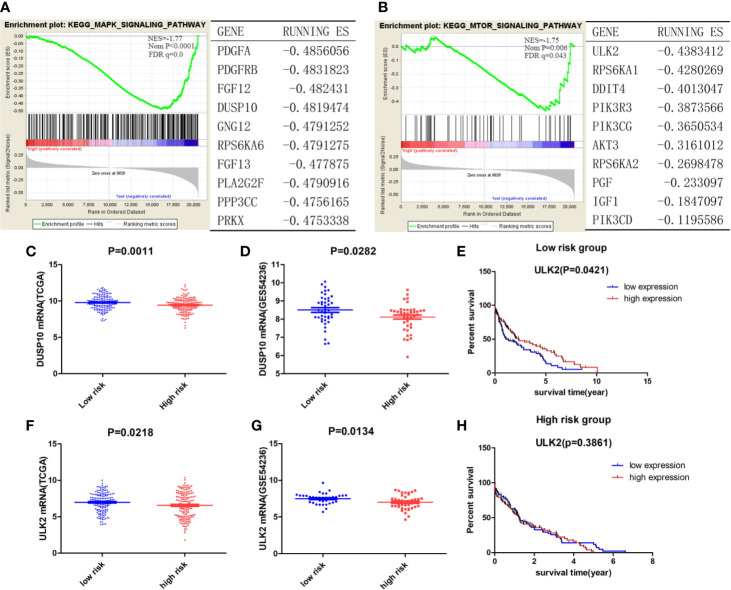

(A, B) The enriched autophagy-related Kyoto Encyclopedia of Genes and Genomes (KEGG) pathways and the corresponding top ranked ranking genes in the low-risk group. Genes fulfilling the criteria p < 0.05 and FDR q < 0.25 were considered significant. Expression of DUSP10 in the low- and high-risk groups in both the TCGA (C) and GEO (D) datasets. Expression of ULK2 between low- and high-risk groups in both the TCGA (F) and GEO (G) datasets. Survival analysis of patients with high/low ULK2 expression in the low- (E) and high-risk (H) groups.